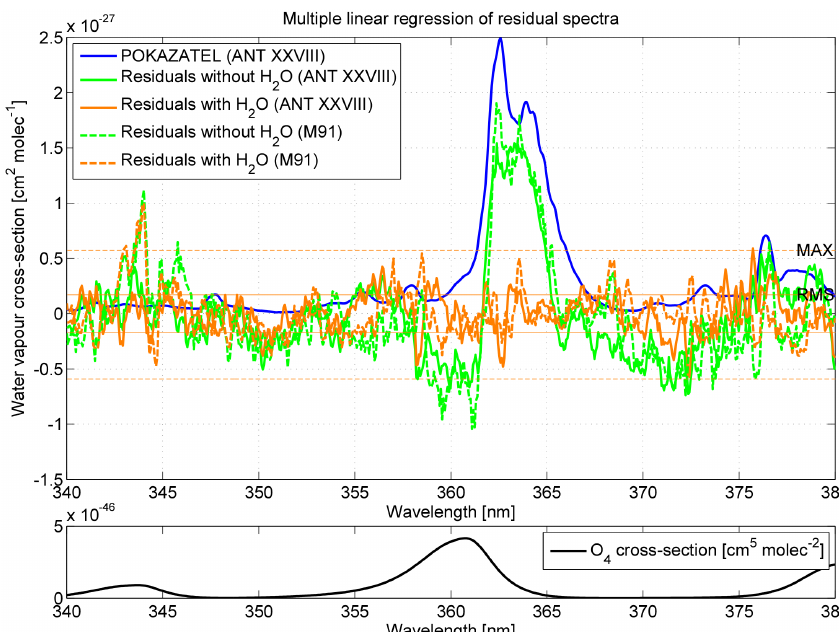
Figure 10. Using a multi-linear regression on the residual spectra from the campaigns ANT XXVIII/1-2 and M91, the water vapour dSCD- correlated residual structures were obtained. Negative values can be explained by compensation of the missing water vapour absorption structures by other absorbers included in the DOAS fit. The resulting spectrum, including water vapour absorption, yields an estimate on the accuracy of the convolved cross